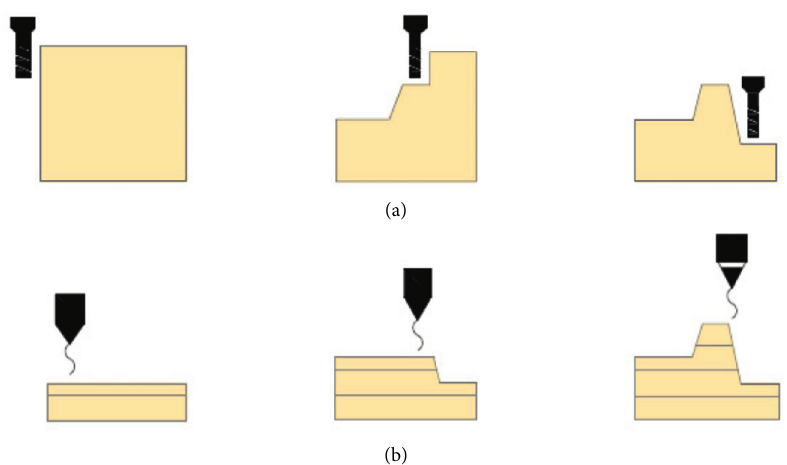
Figure 1: Comparison of (a) subtractive manufacturing and (b) additive manufacturing